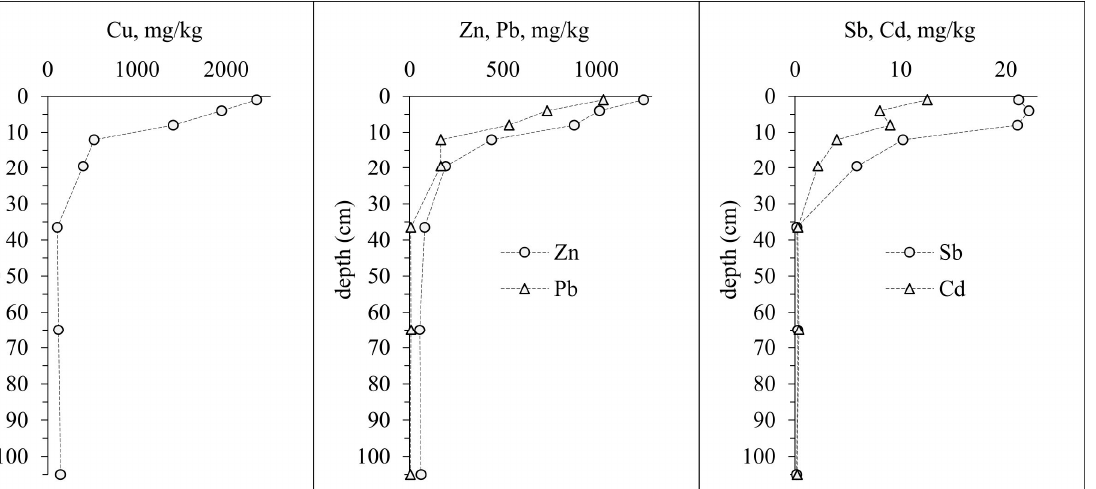
Figure 3. The vertical distribution of heavy metals in sediments of Lake Ufimskoe (Chelyabinsk Region) [19].